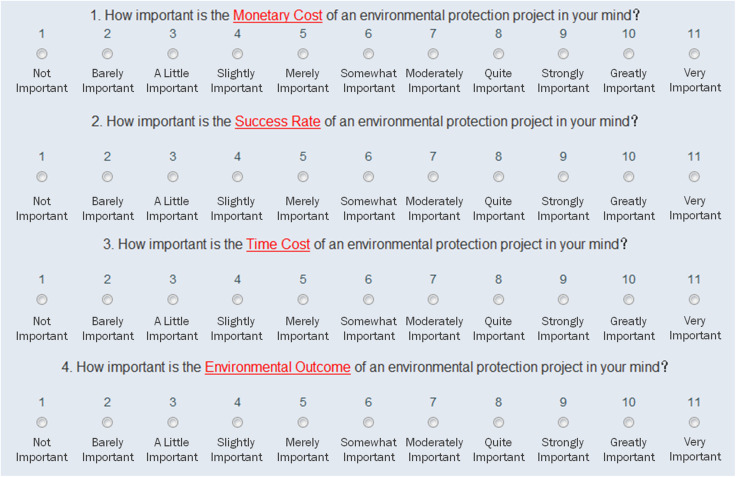
Eleven-point scales used in preliminary study.